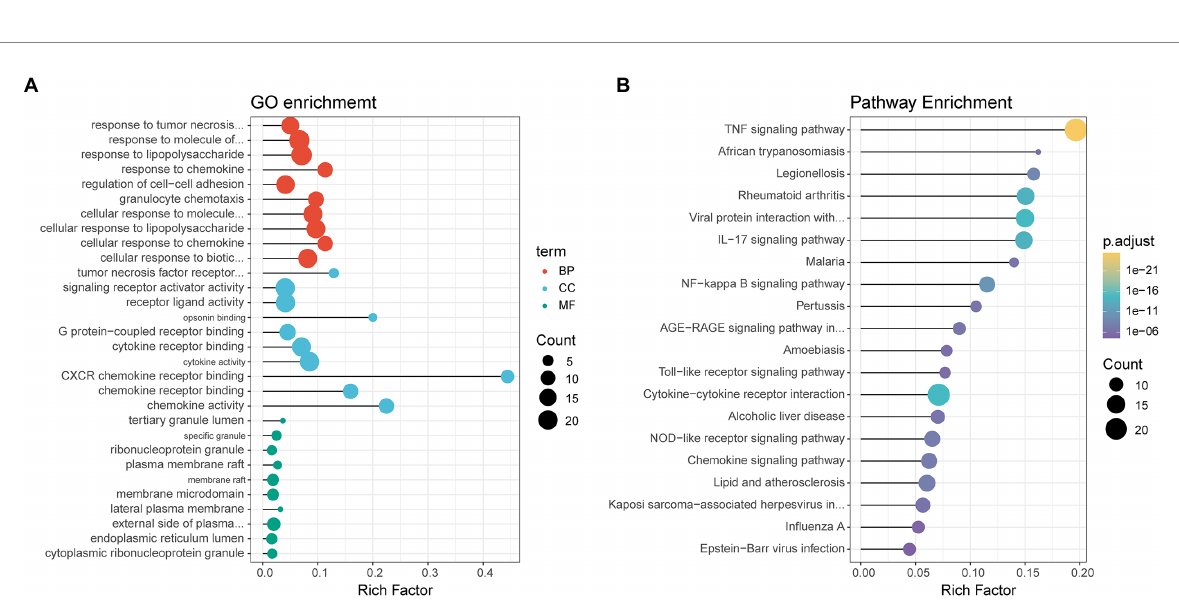
FIGURE 3 Dot plots displaying enriched GO terms (A) or KEGG pathways (B) of identified DEGs. Dot size represents the count of the enriched gene within each category, and the x-axis represents the gene ratio (rich factor). The GO terms/KEGG pathways are arranged on the basis of the value of the gene ratio, not on their adjusted p value, for easier visualization